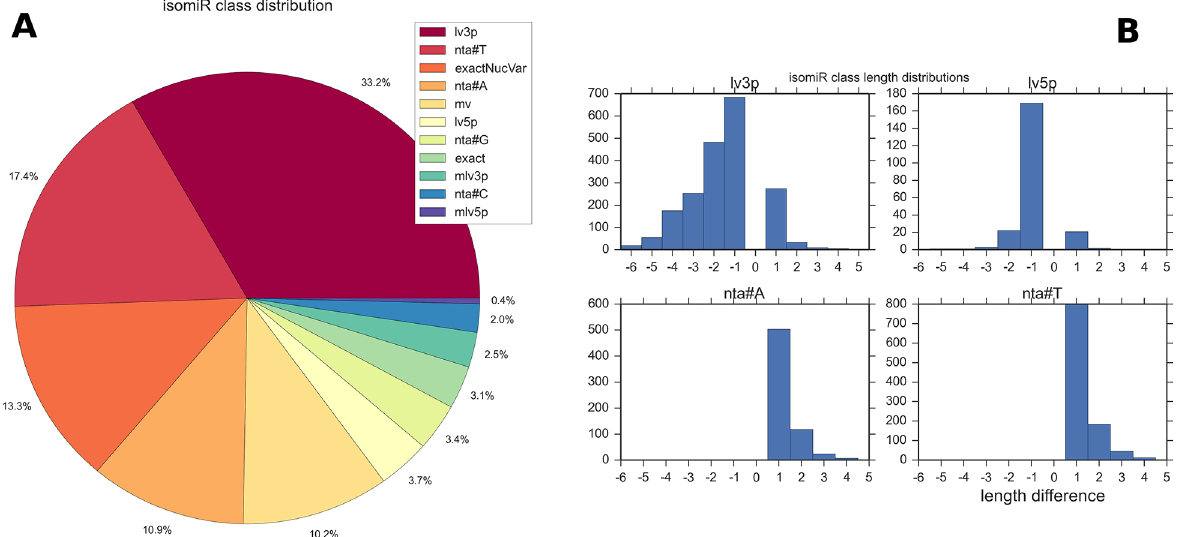
Fig 5. Isomir results. A: The relative frequencies of all isomiR classes including exact matches to the reference. nta# * denote non-templated additions, lv3p and lv5p the 5' and 3' length variants and mv denotes variants different at both ends. Classification is according to the sRNAbench hierarchical scheme. B: Length distributions for 5' and 3' variants showing the large variation in the latter. (x-axis shows length difference from canonical form). A number of the extreme 3' trimmed sequences are possibly due to erroneous mapping of short reads < 18nt.